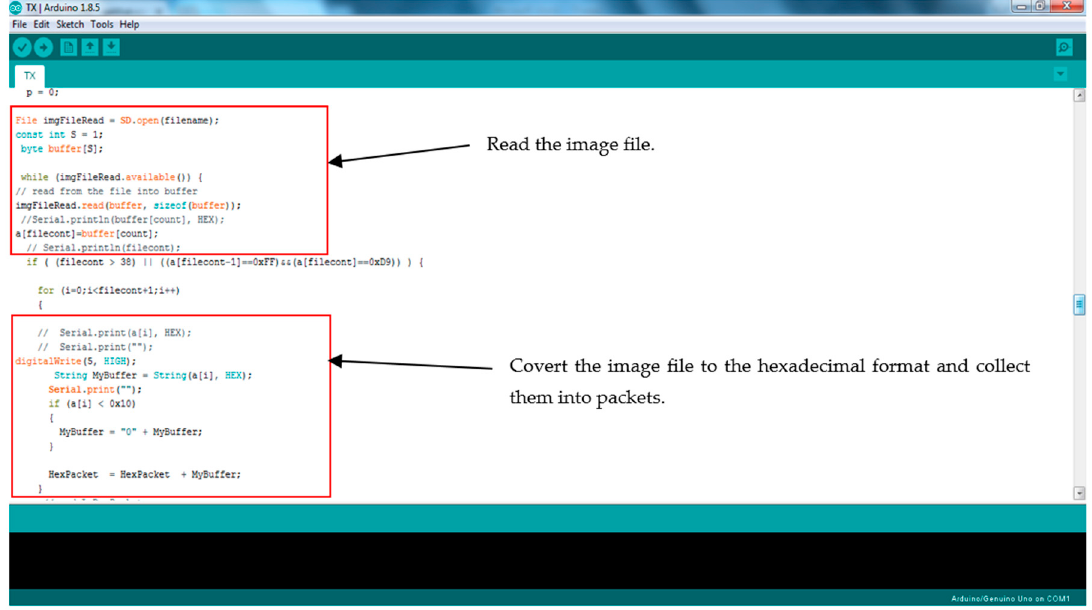
Figure A2. Arduino code for converting the captured image into hexadecimal packets.